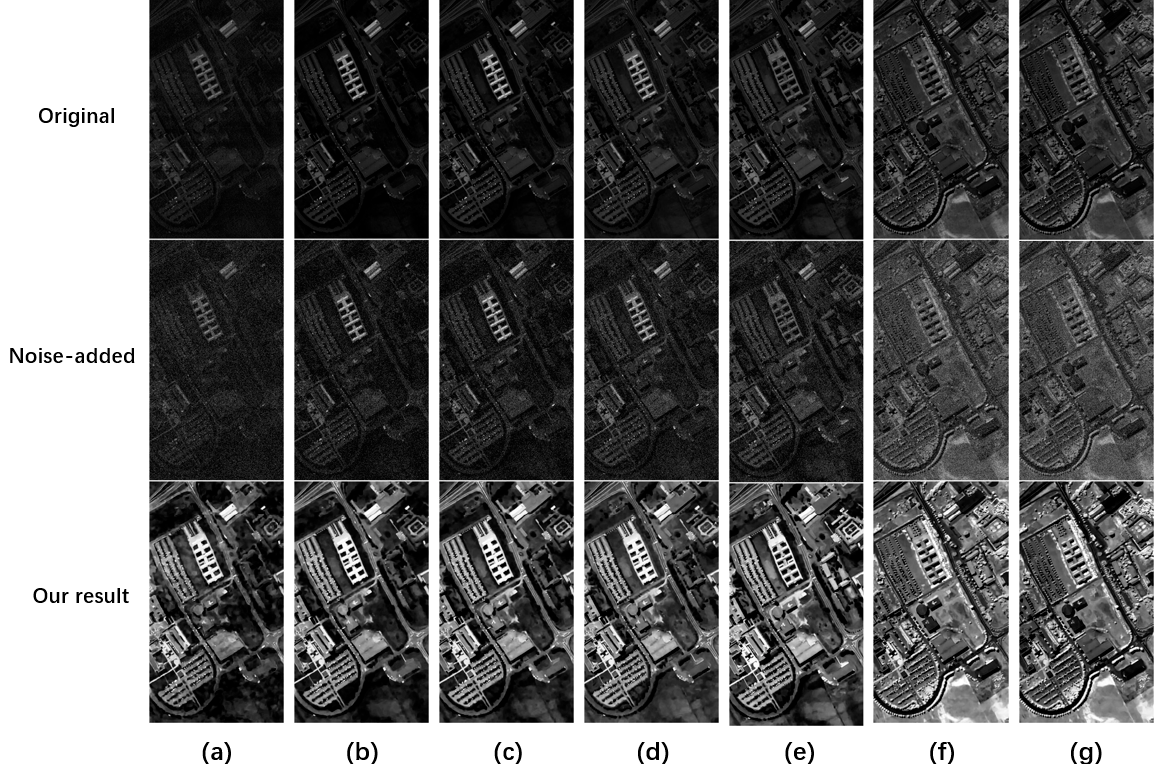
Figure 4. Visualization results of the Pavia University dataset at different bands. The first row represents the original data. The second row represents the degraded map with added noise ( σ = 5). The third row represents the quality improvement result. Each column from left to right represents